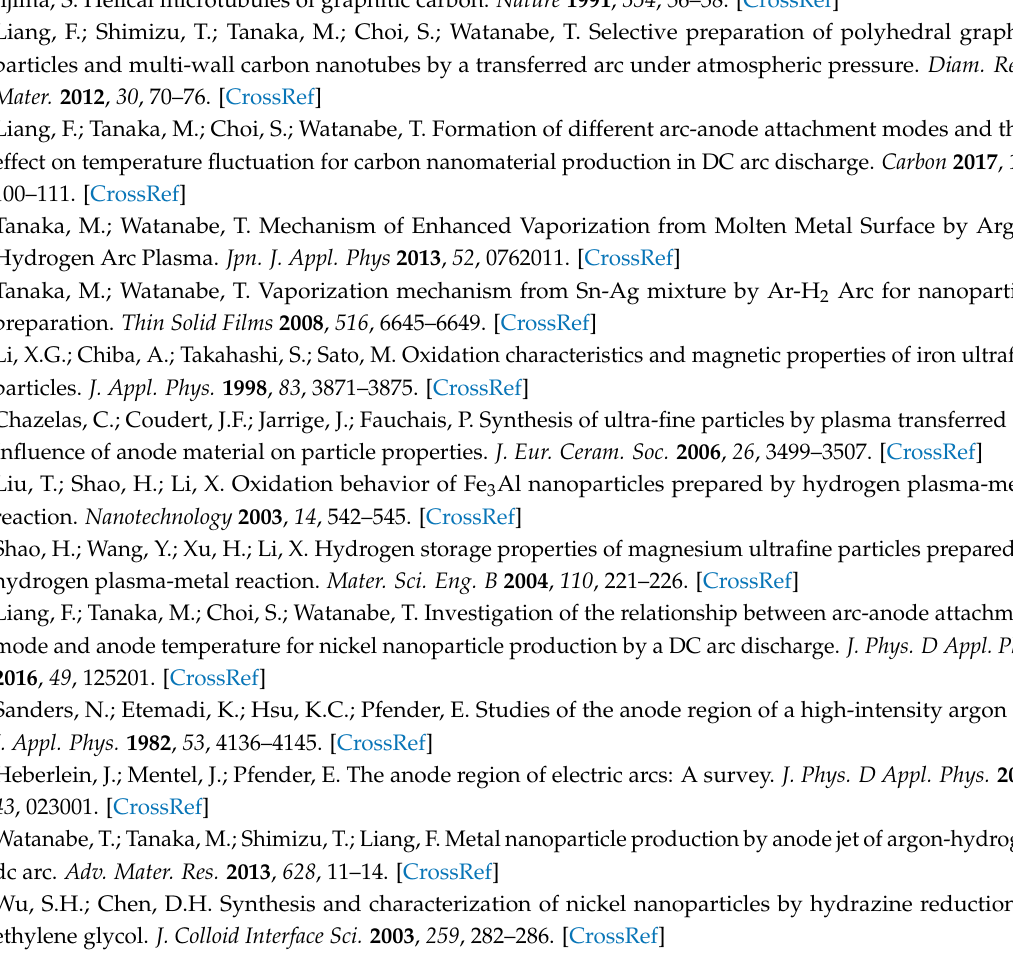
Figure S1: (a) Schematic of a typical hybrid Na-air battery, (b) structure of the catalyst layer; Figure S2: The formation mechanism of metal nanoparticle by arc discharge method; Figure S3: (a) Discharge voltage profiles of hybrid Na-air batteries with Ni nanoparticles, Ag nanoparticles and carbon black as catalyst at different current densities. (b) Current density dependence of discharge voltage for batteries with different catalysts. The plots correspond to the measured data, and the solid lines indicate the fitted spectra; Figure S4: (a) TEM image of the Ni nanoparticles. (b) SAED pattern for the Ni nanoparticles; Figure S5: XPS spectra of Ni nanoparticles presented by arc discharge